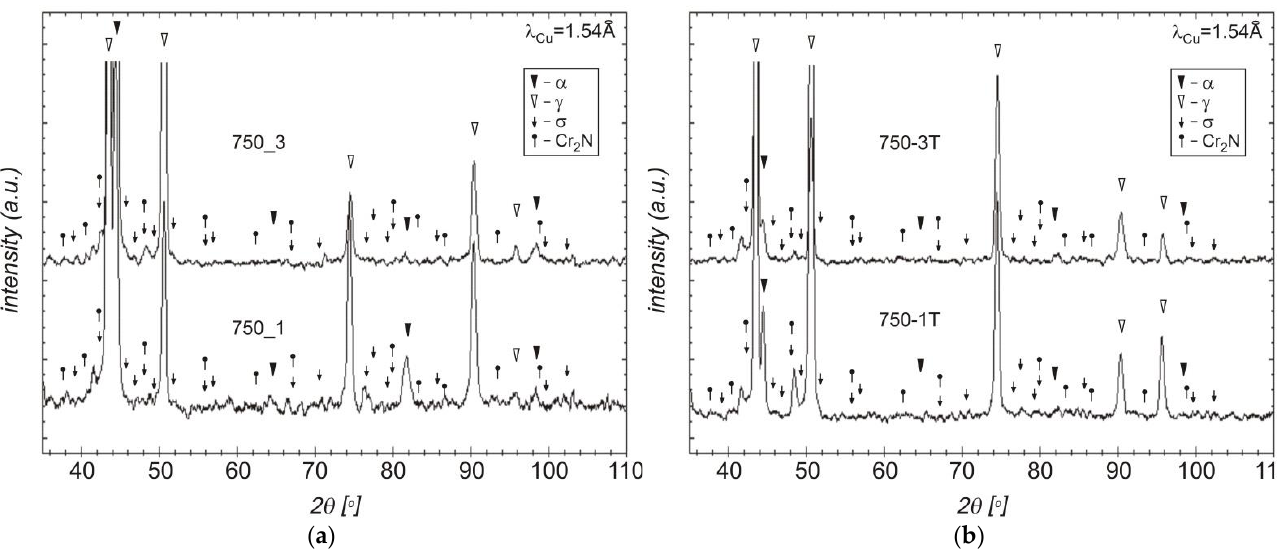
Figure 6. Tested cast steel held at 750 °C for 3 h — Mo distribution in precipitate shown in Figure 5b.